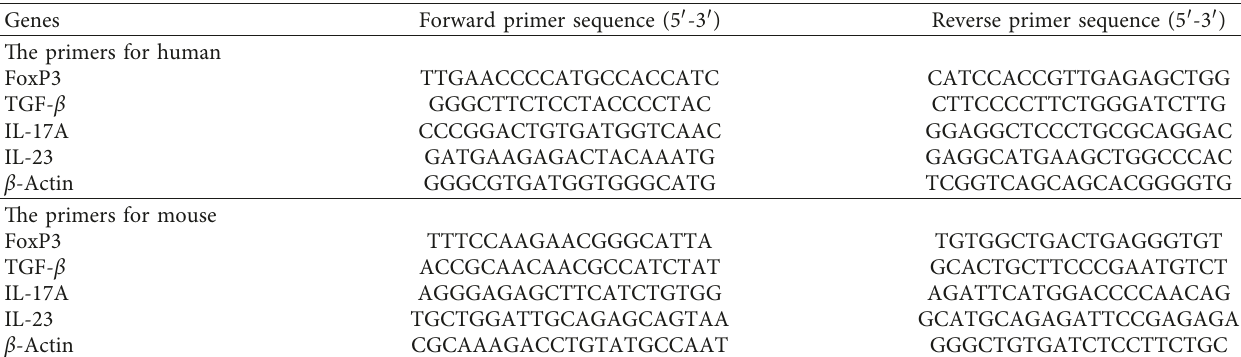
Table 1: The primers used for real-time